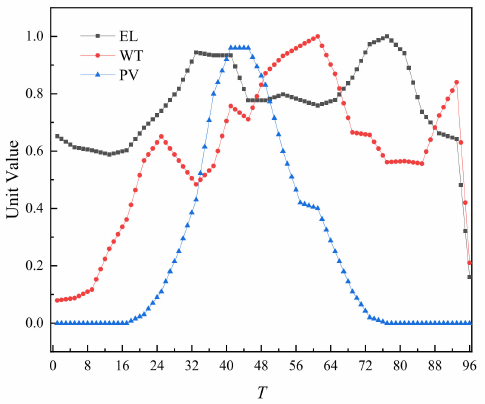
Figure 4. Fiducial value of load, wind power, and photovoltaic